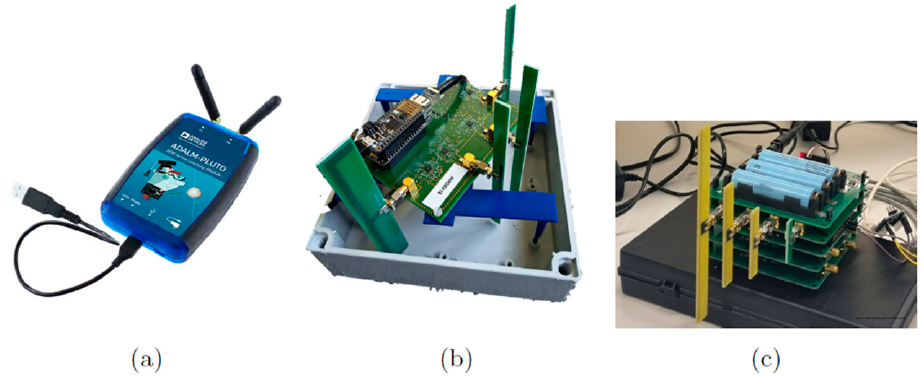
Figure 1. ( a ) Adalm Pluto SDR; ( b ) WAVES sensor; ( c ) S 3 R sensor.